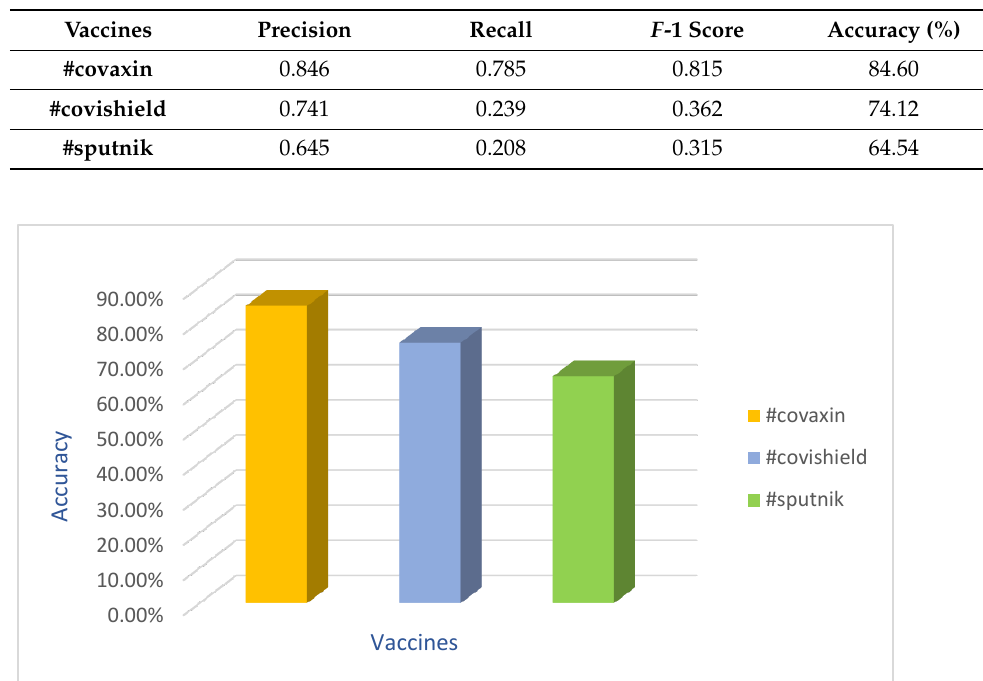
Table 3. Precision, recall, F -1 score, and accuracy of the proposed sentiment analysis method for the respective vaccines.